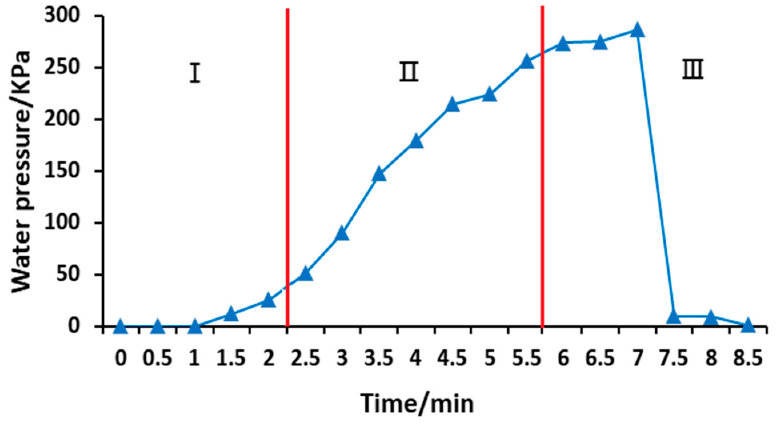
Figure 12. Water pressure variation of aquifuge rock in the process of water inrush in the vault